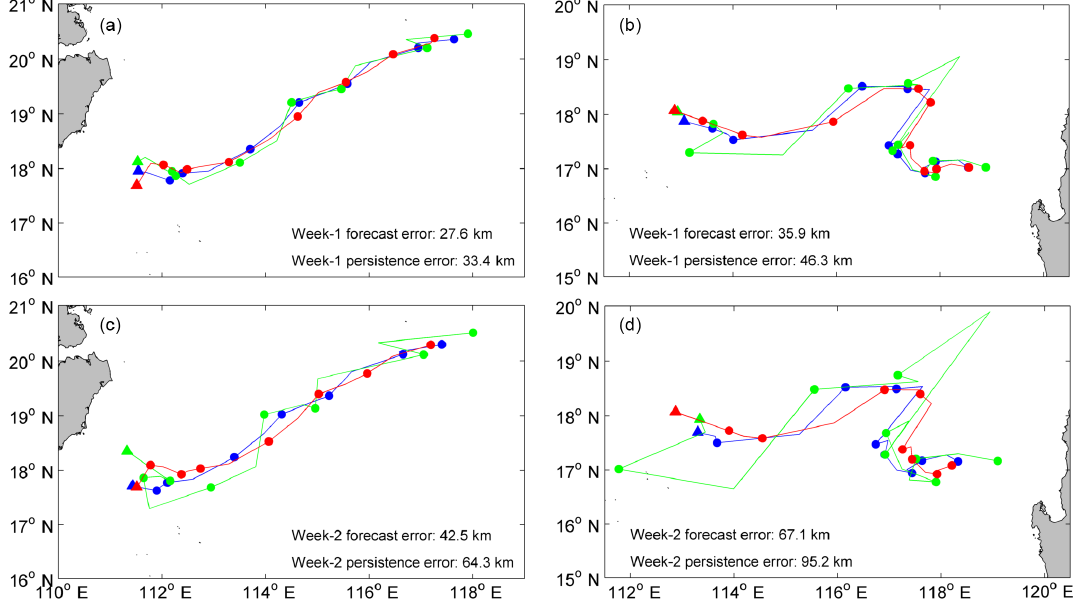
Figure 5. A comparison of the satellite observed trajectory (red), the trajectory predicted by our model (blue) and persistence trajectory (green) at (a) week 1 and (c) week 2. (b) and (d) are the same as (a) and (c) , respectively, but for a recurved trajectory. The biweekly eddy positions of each trajectory are shown by the solid circles. The ending position of each trajectory is represented by the solid triangle.